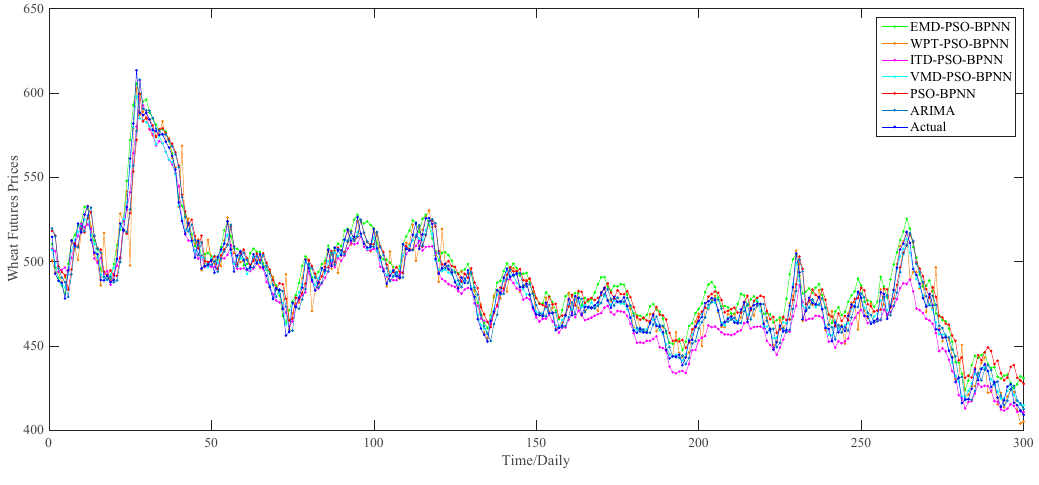
Figure 11. One-day-ahead forecasting results of different models of wheat.